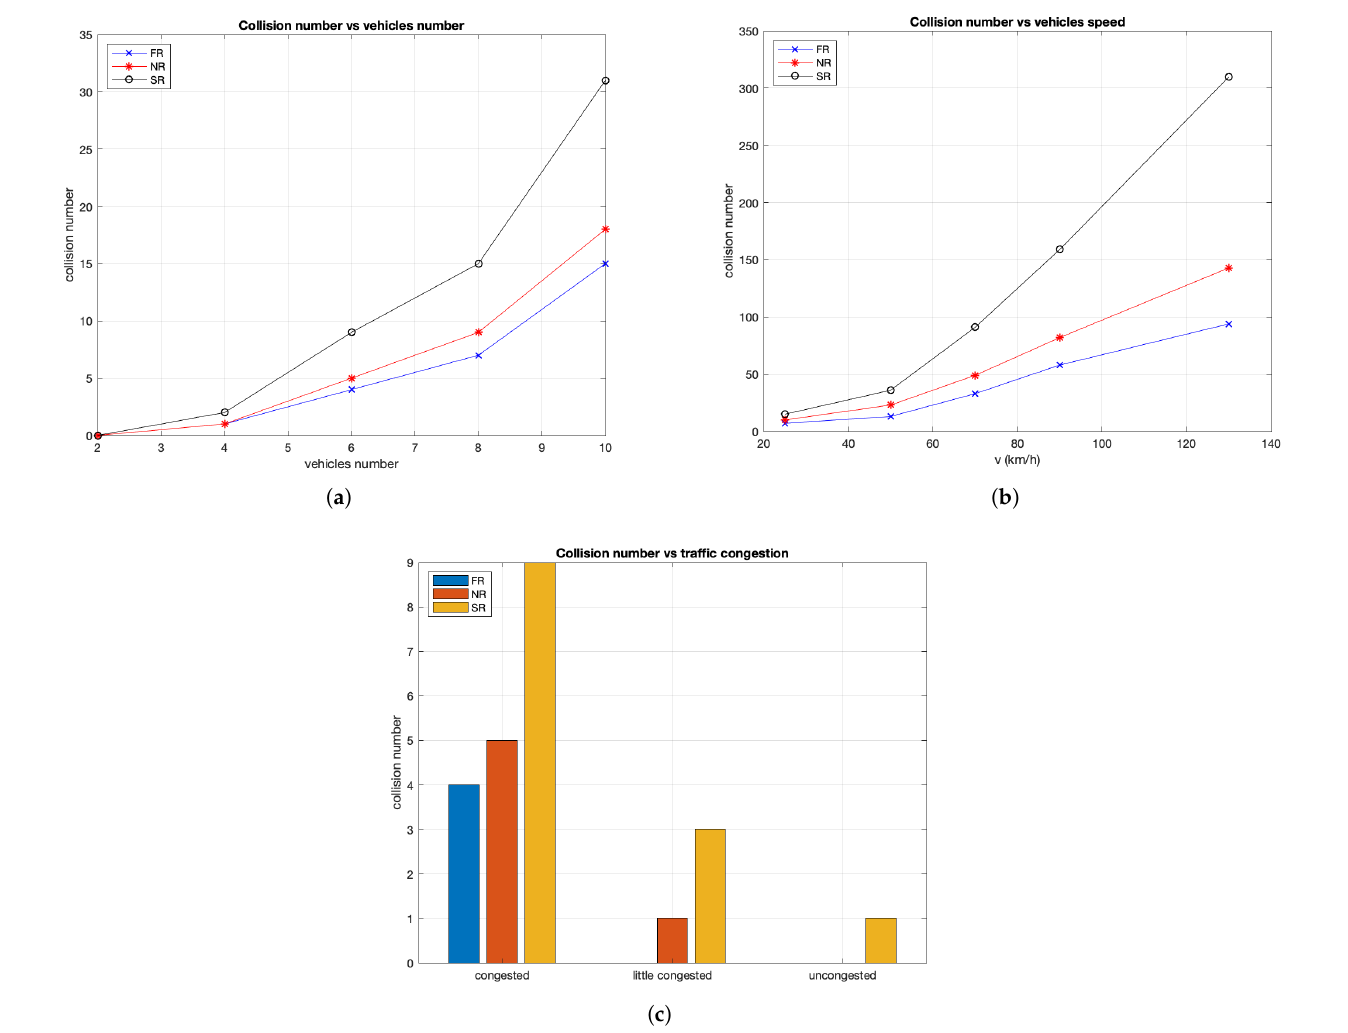
Figure 9. Number of collisions varying: ( a ) vehicle number; ( b ) vehicle speed; and ( c ) traffic